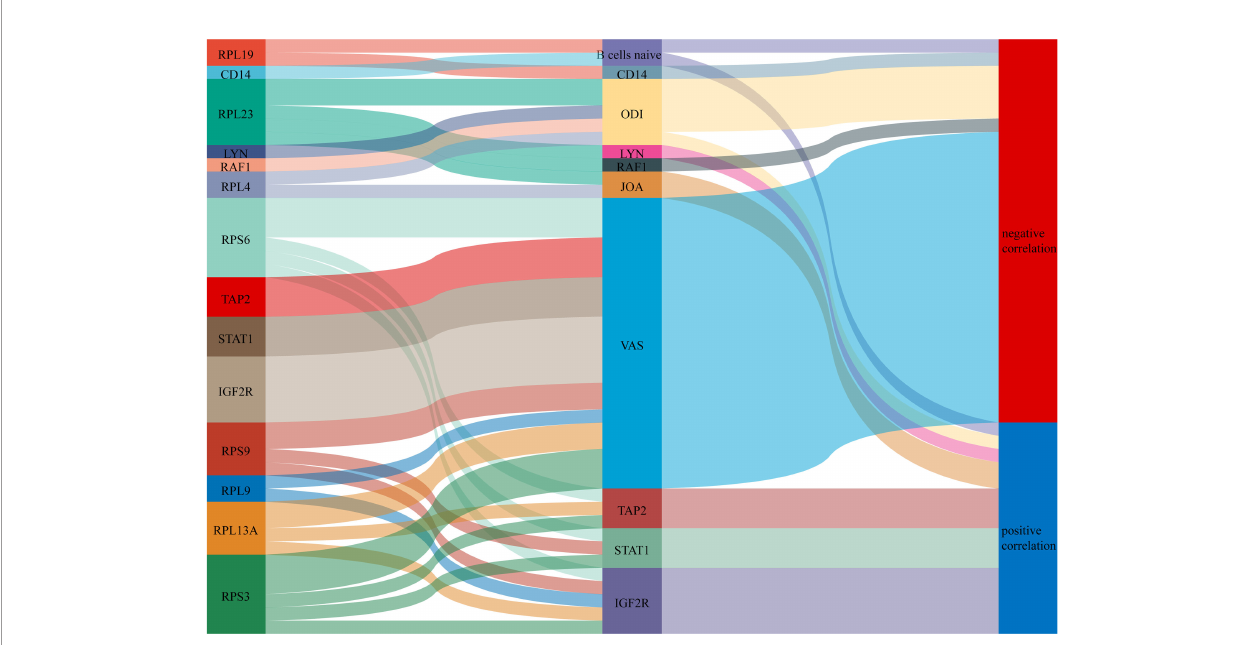
FIGURE 12 | A Sankey diagram was plotted showing the relationship between COVID-19-related proteins regulating immune genes and clinical